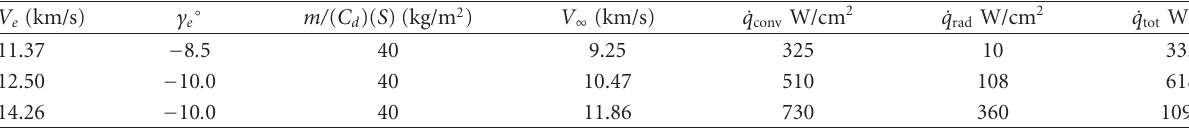
Table 7: Stagnation point radiative heating rate comparisons for FIRE II.